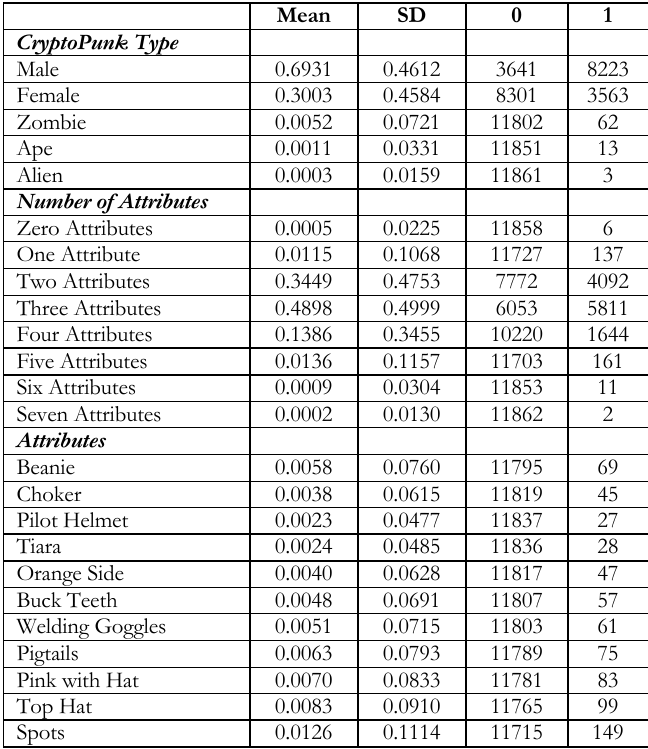
Table 3: Descriptive Statistics of the Hedonic Variables of CryptoPunks with N =